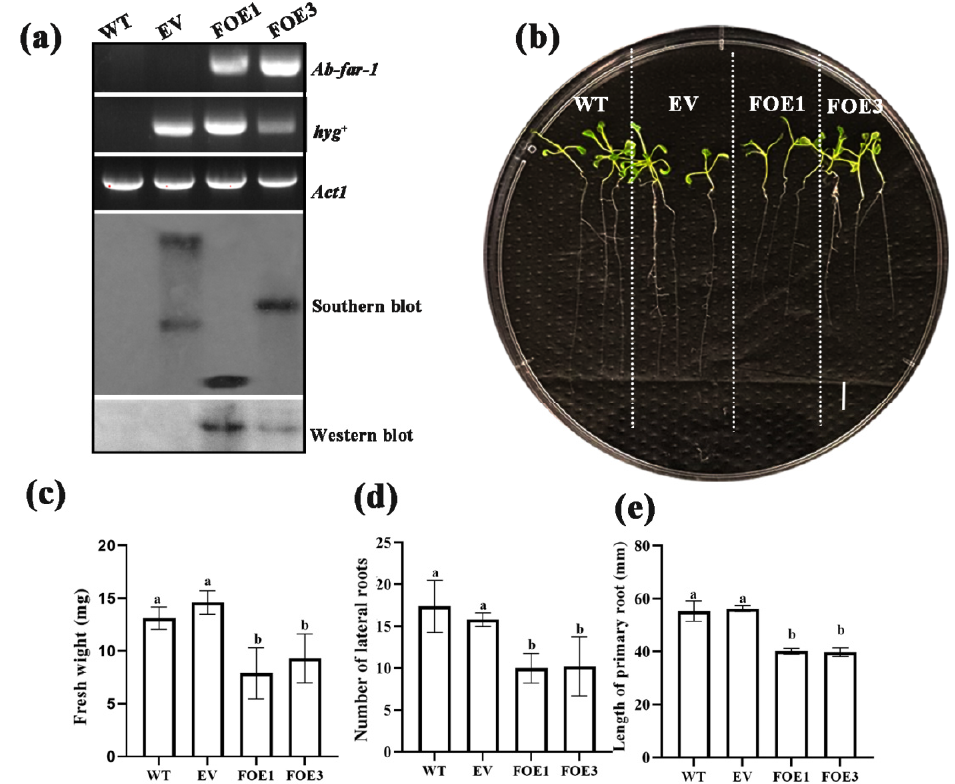
Figure 4. Phenotypic changes in Ab-FAR-1 ∆ sp overexpressing Arabidopsis thaliana . ( a ) Molecular detection of Ab-FAR-1 ∆ sp overexpressing lines. The phenotypes ( b ), fresh weight ( c ), number of lateral roots ( d ) and length of primary roots ( e ) of Ab-FAR-1 ∆ sp overexpressing lines. WT, Wild type Col-0 ecotype A. thaliana ; EV, A. thaliana transformed with empty vector; FOE1 and FOE3, Ab-FAR-1 ∆ sp overexpressing A. thaliana line 1# (FOE1) and 3# (FOE3); Ab-far-1 , PCR fragment bands of Ab-far-1 gene; hyg + , PCR fragment bands of hygromycin resistance gene; Act1 , reference gene Act1 . Values are shown as means ± SE, n = 10. Different letters above bars denote values that are significantly different from each other ( p < 0.05, Tukey’s test). There were three independent biological replicates. Bar = 10 mm.